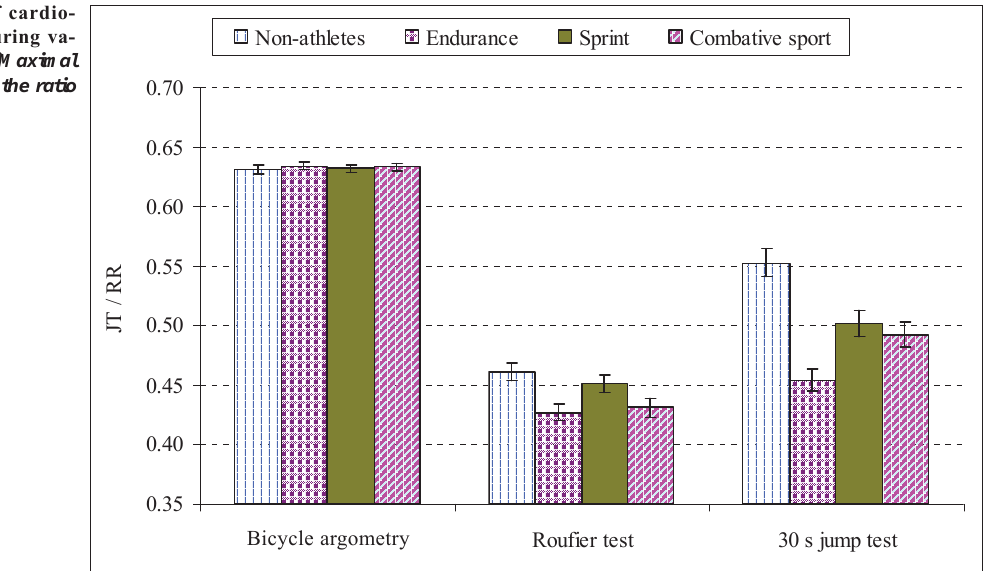
MOBILIZATION OF CARDIOVASCULAR FUNCTION AT ONSET OF EXERCISE AND PECULIARITIES OF RECOVERY IN DEPENDENCE ON THE TYPE OF Fig. Mobilization of cardio- vascular function during va- rious exercise tests (Maximal values in changes of the ratio JT / RR)